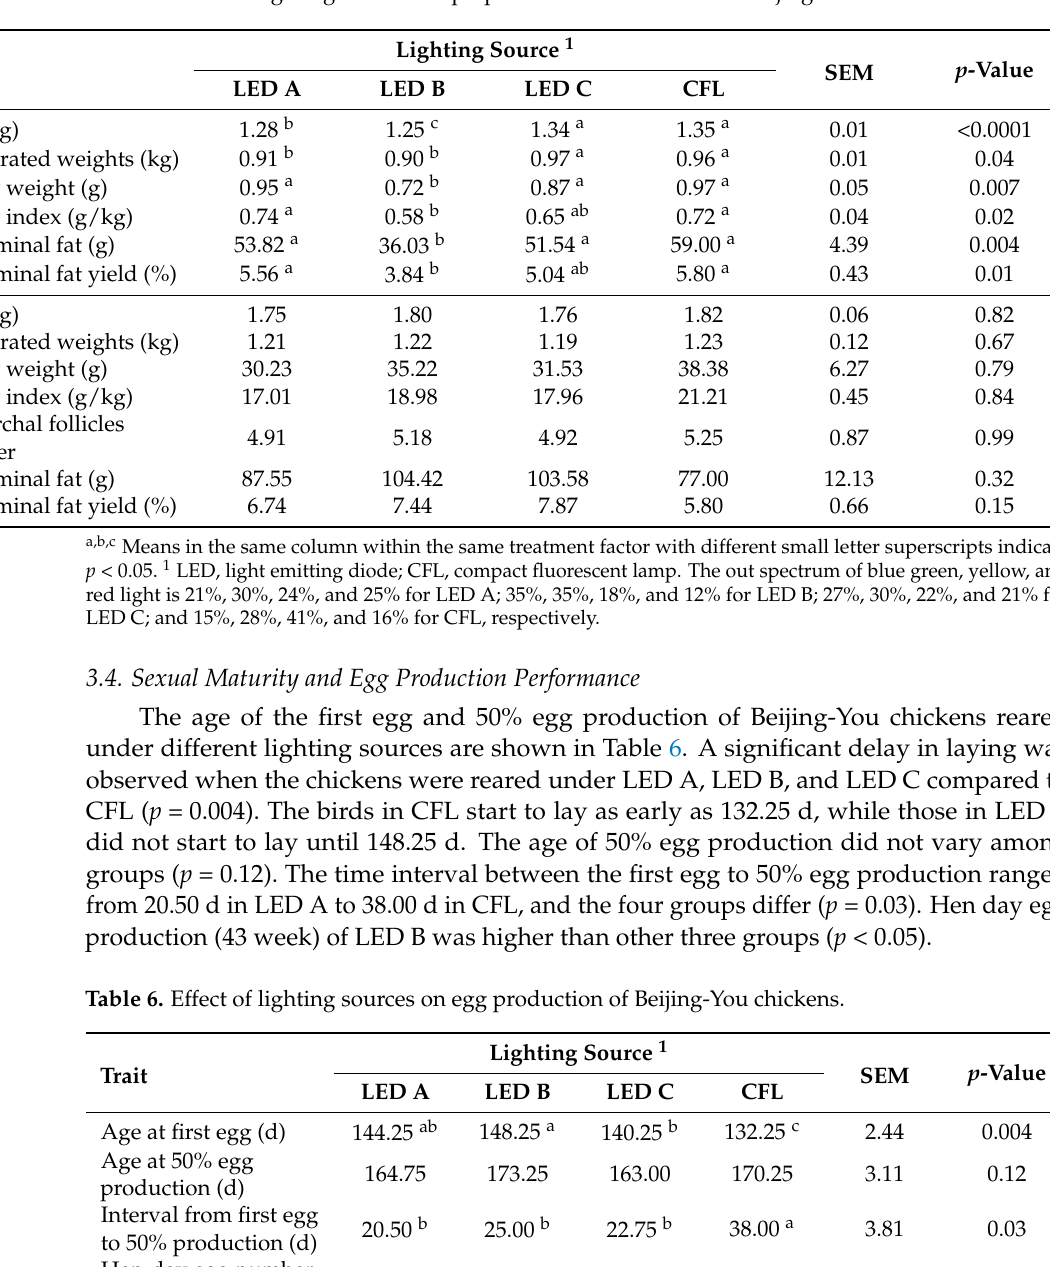
Table 5. Effect of lighting sources on prepubertal characteristics of Beijing-You chickens.